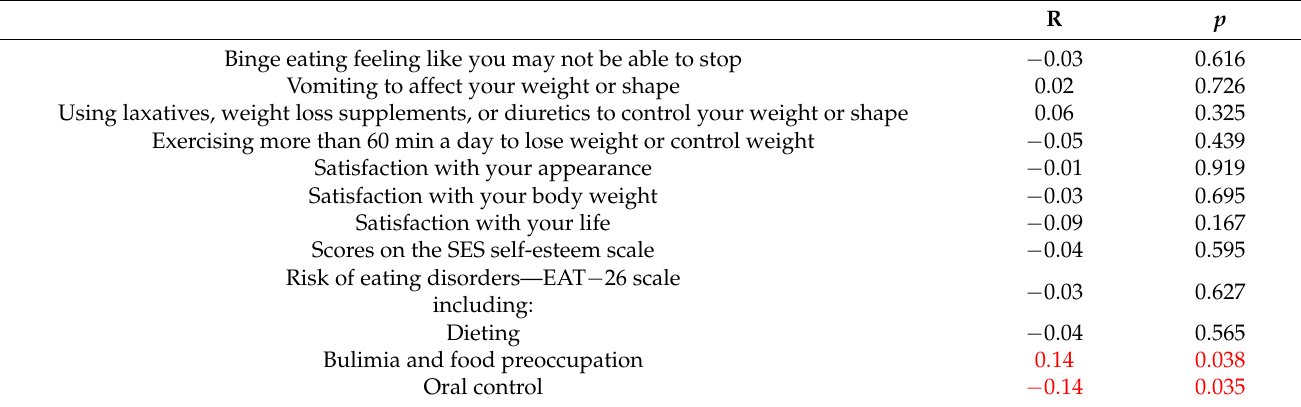
Table 2. Influence of age on respondents’ answers to selected questions.